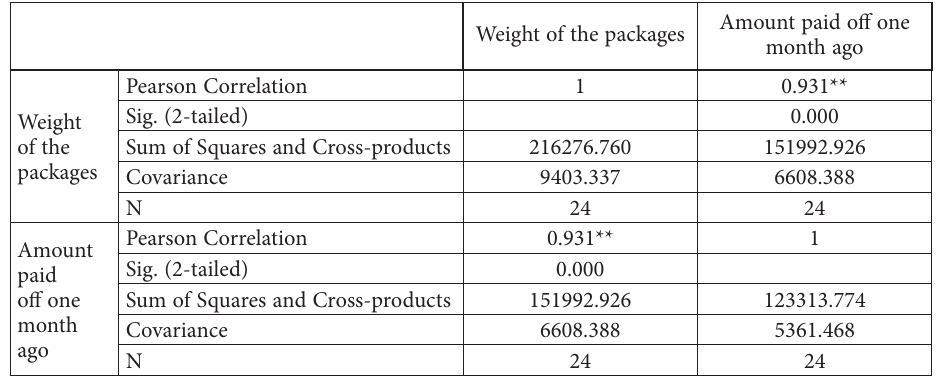
Table 4. Determining the Pearson correlation